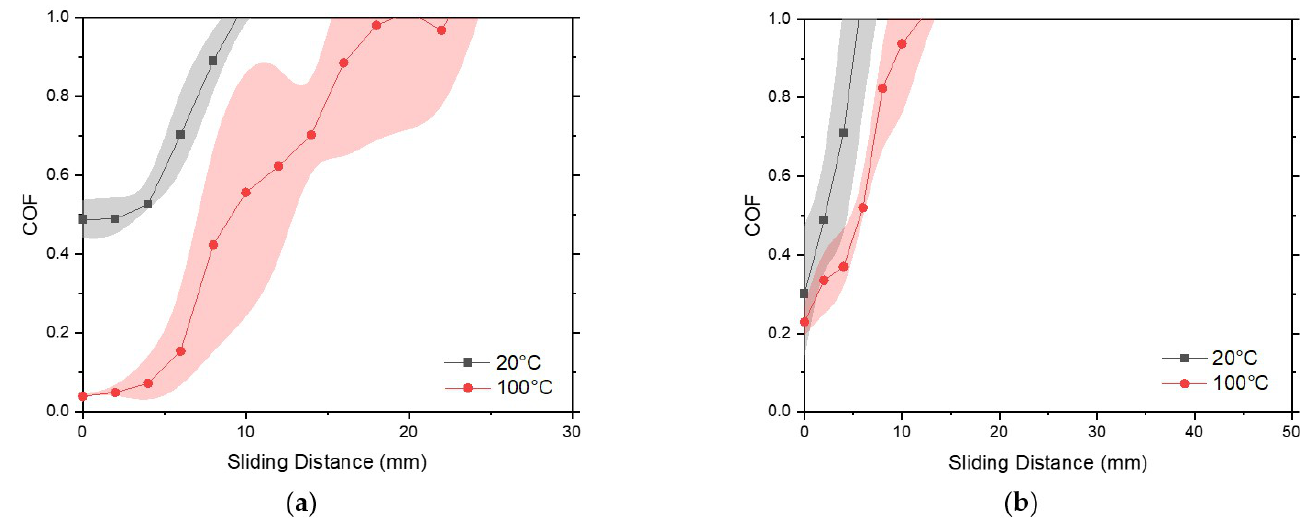
Figure 5. The friction test results of different tool temperatures with a blank temperature of 350 ◦ C for: ( a ) lubricant A; ( b ) lubricant B. The connected scatter lines represent the average coefficient of friction values while the shadows represent the standard